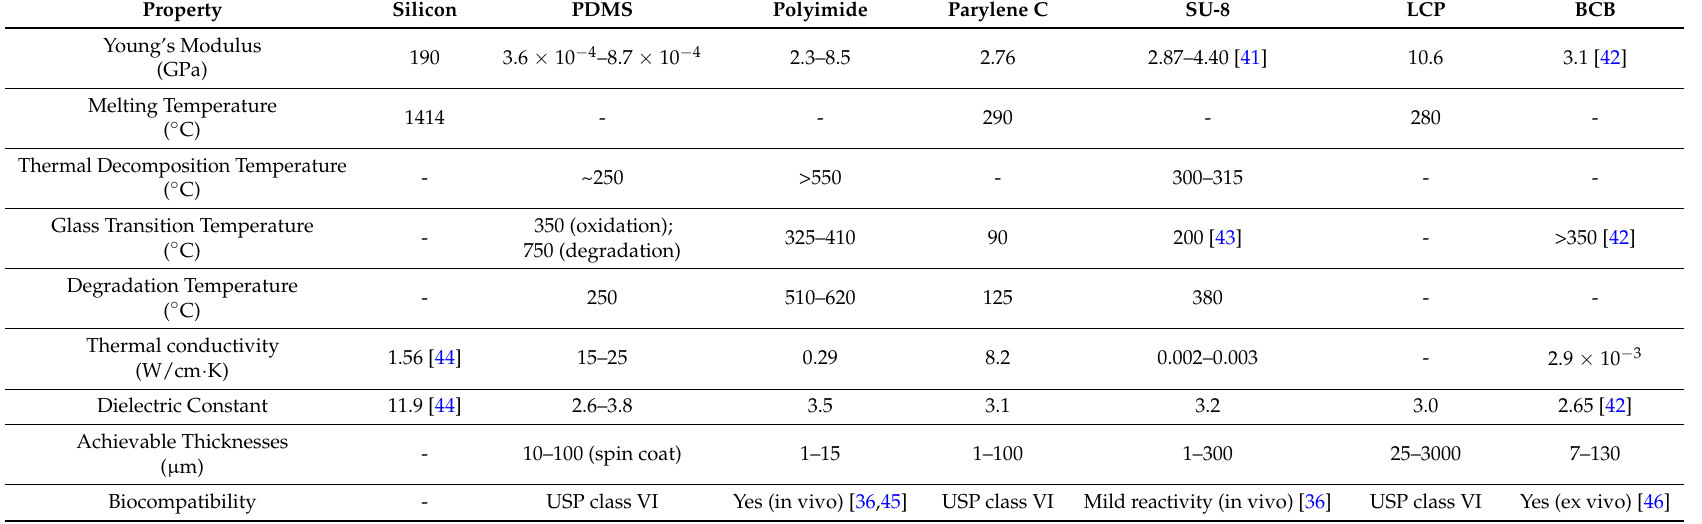
Properties of polymers for neural implants (silicon for reference). Values from Scholten [40] and Hassler [36] unless otherwise noted. PDMS: Polydimethylsiloxane; Parylene: Poly(p-xylylene); LCP: Liquid crystal polymer; BCB: Benzocyclobutene; USP: United States